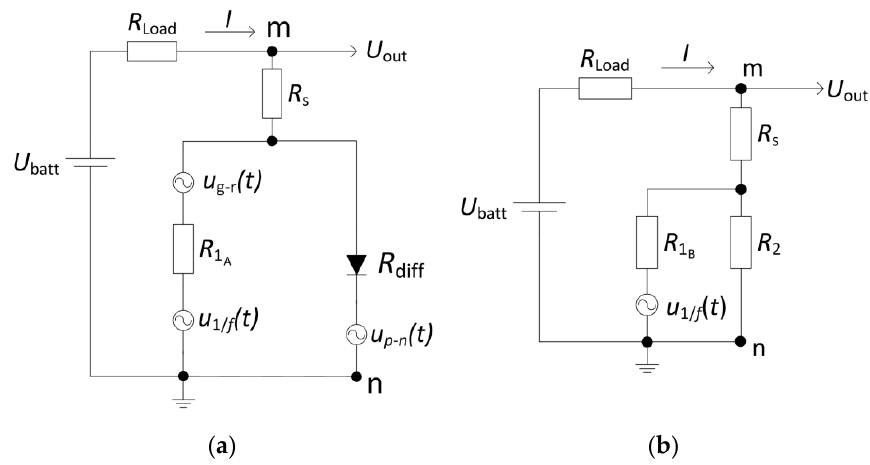
Figure 8. Equivalent electrical circuits of group A ( a ) and group B ( b ) LDs with the voltage noise sources ( R Load >> R mn ).